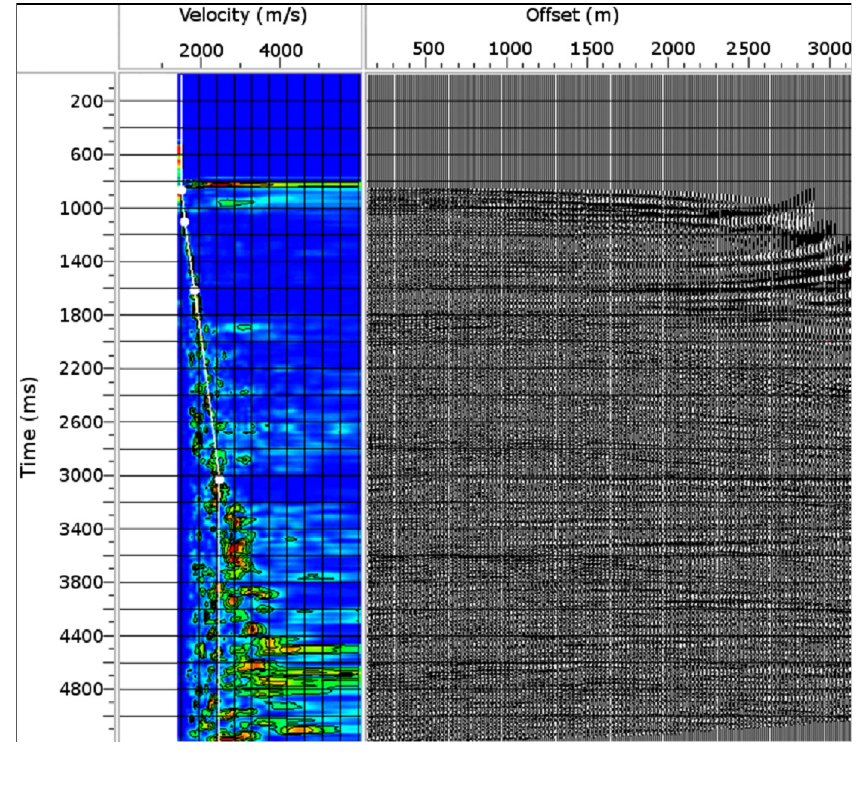
Figure 7. Velocity spectrum (left) and respective NMO correction (right) for the CMP gather 977. Estimated velocities (points on the white curve) were obtained through the non- hyperbolic approximation of Castle